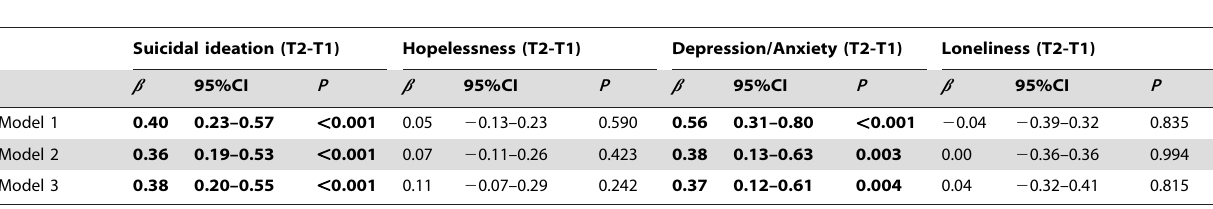
Table 3. Relationships between suicide-related or mental health consultation-related internet use and changes in mental health scores between T1 and